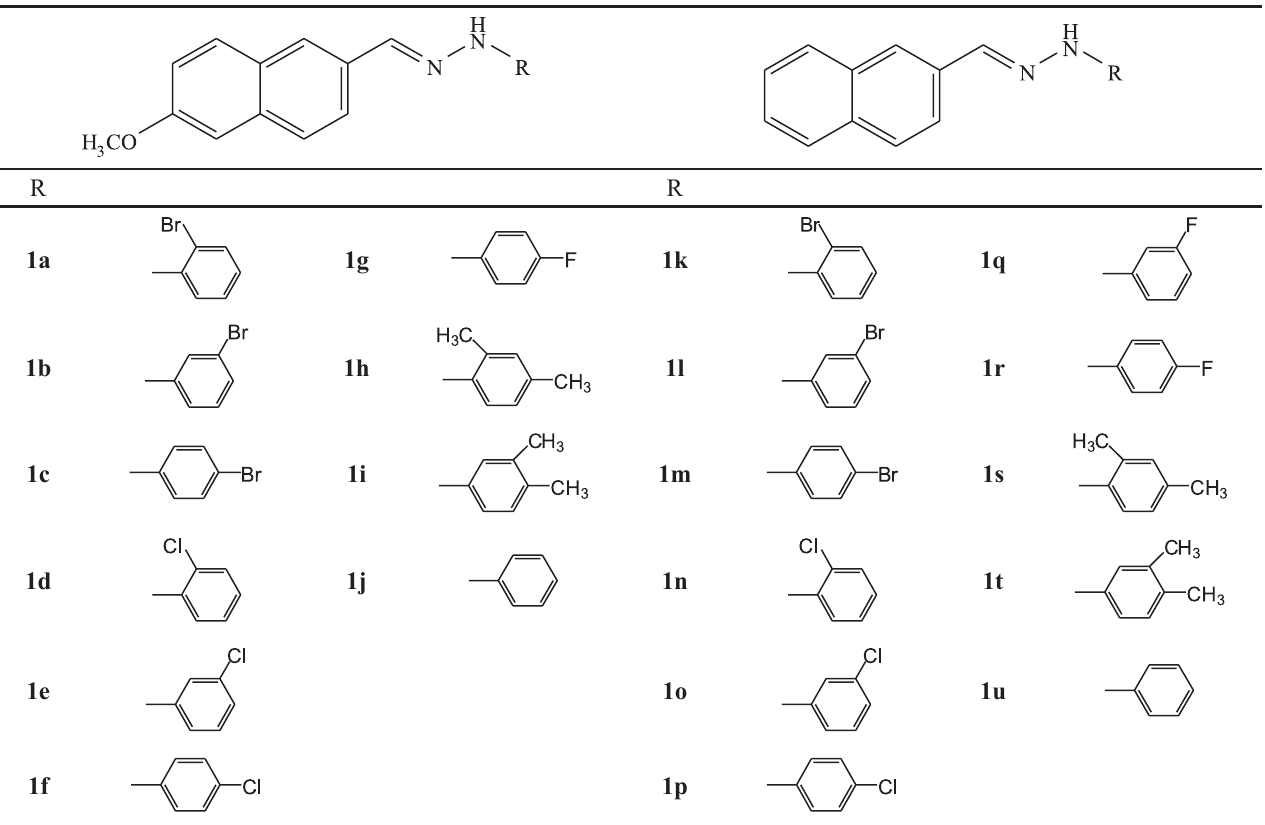
TABLE I - Chemical structures of newly synthesized compounds